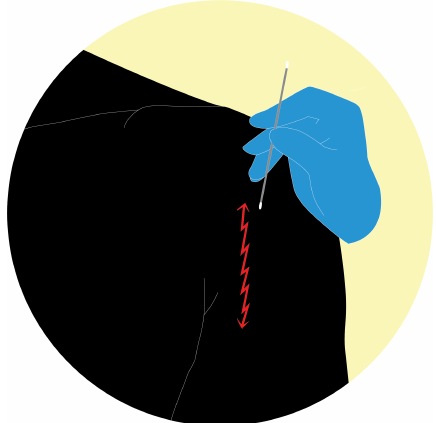
Figure 2. PES technique: rub the swab with an oscillating move- ment – like using a pencil eraser – going down over a 10cm line and then in the same manner up again for a total of 15 passages (https://doi.org/10.5446/55554; Scheer, 2021a).